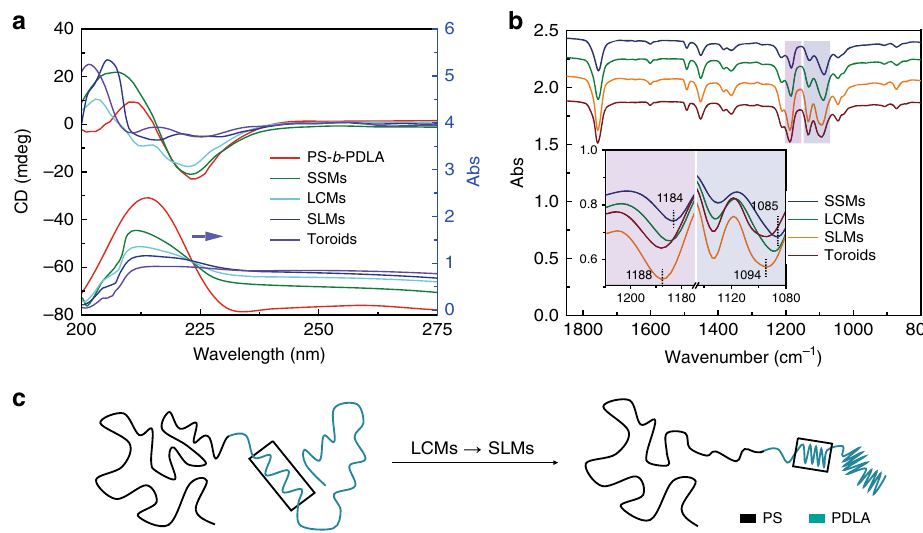
Fig. 7 Conformation change of PDLA chains during the self-assembly. a CD (top) and UV-vis (bottom) spectra of PS- b -PDLA in dilute THF solution, and the assemblies in mixed solvents obtained at varied water content during the formation of BCPs toroidal micelles. b FT-IR spectra of the assemblies. c Schematic illustration of conformation change for PDLA chains from loosely staggered conformation to compact gauche conformation corresponding to the morphological